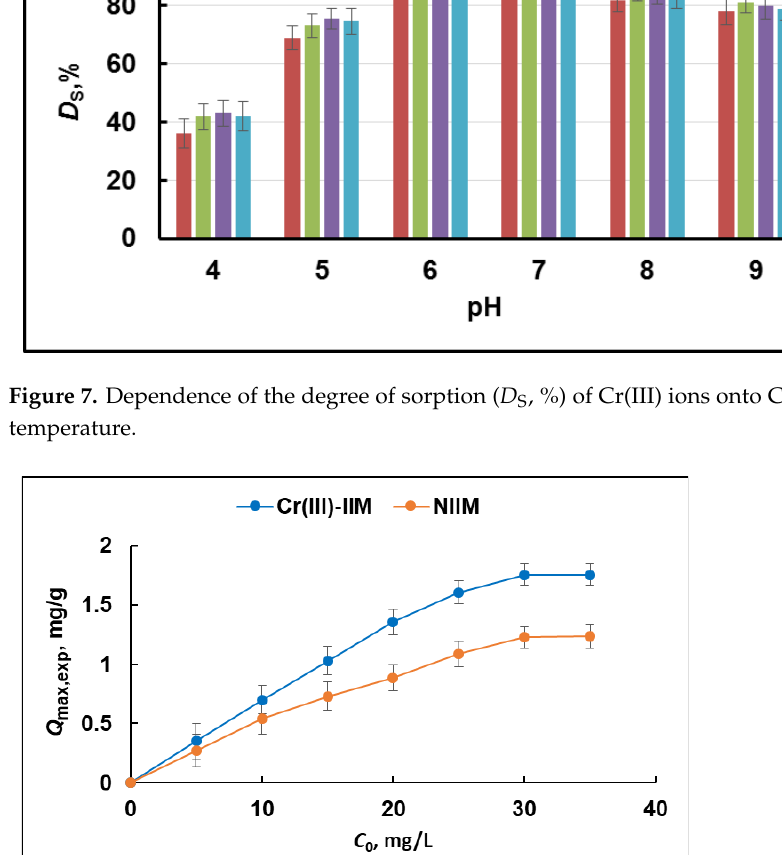
Table 1. Degree of elution D E (%) of Cr(III) from Cr(III)-IIM using different eluents.